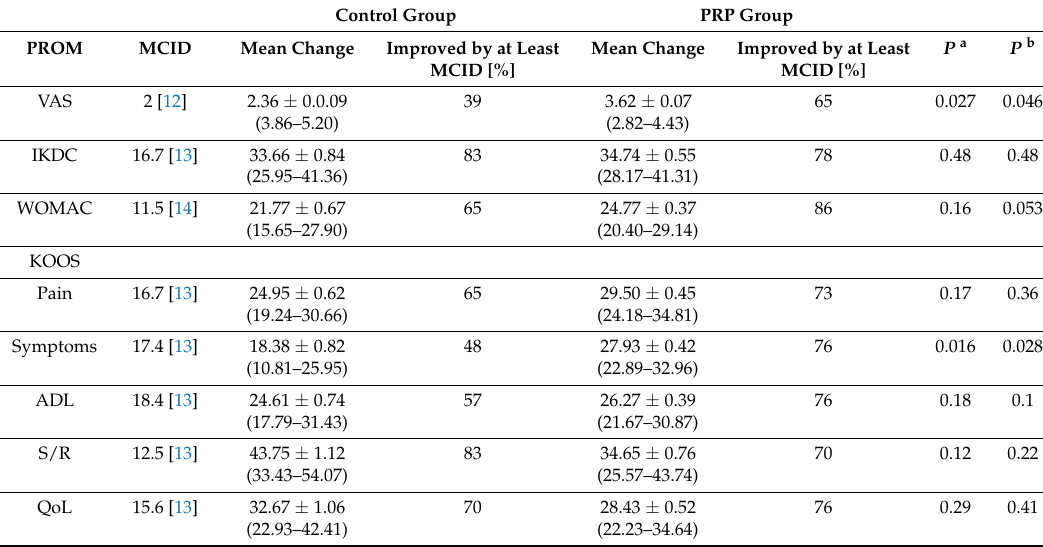
Table 4. Patient-reported outcome measures (pain: VAS and KOOS-pain; function: IKDC, WOMAC, KOOS: symptom, ADL, sport/recreation and